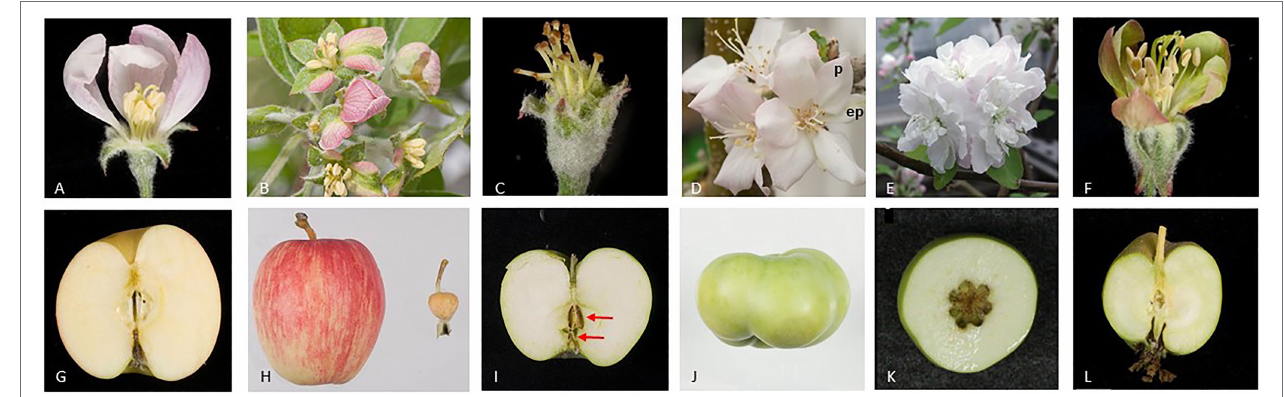
FIGURE 3 | Apple flower and fruit phenotypes after alteration of the expression of floral organ genes. The images show open flowers (A–F) and mature fruit (G–L) of wild-type (A,G) and transgenic apple plants (B–F, H–L) . miR172 is known to inhibit the expression of the AP2- and AP2-like genes. miR172 over-expression converts sepal segments to petal-like tissues (B) outer petals are removed to show sepal-petal conversion and dramatically reduces fruit size (H) , wild-type fruit on left and transgenic fruit on right (Yao et al., 2015). Repressing expression of the MdPI gene converts petals to sepals, and stamens to carpels (C) , and results in parthenocarpic (seedless) fruit with two whorls of carpels marked using two red arrows (I) . However, over-expressing MdPI converts sepals to petals (p, petal; ep, ectopic petal) (D) and suppresses fruit tissue growth resulting in altered fruit shape (J) (Yao et al., 2001, 2018). Repressing expression of two AG homologs, MdMADS15/22 , converts stamens to petals (E) and increases carpel number and therefore fruit locule number (K) (Klocko et al., 2016). Repressing expression of two SEP homologs, MdMADS8/9 , partially converts petals to greenish sepal-like organs (F) and suppresses fruit flesh growth (L) (Ireland et al.,